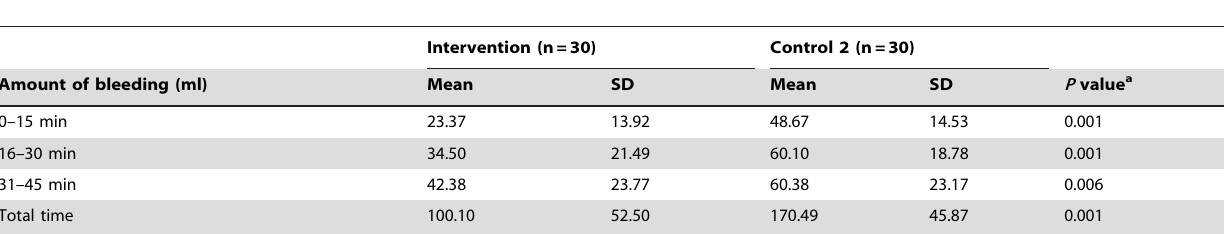
Table 4. The effect of tranexamic acid plus phenylephrine versus phenylephrine alone on the amount of bleeding by duration of time after surgery using ANOVA